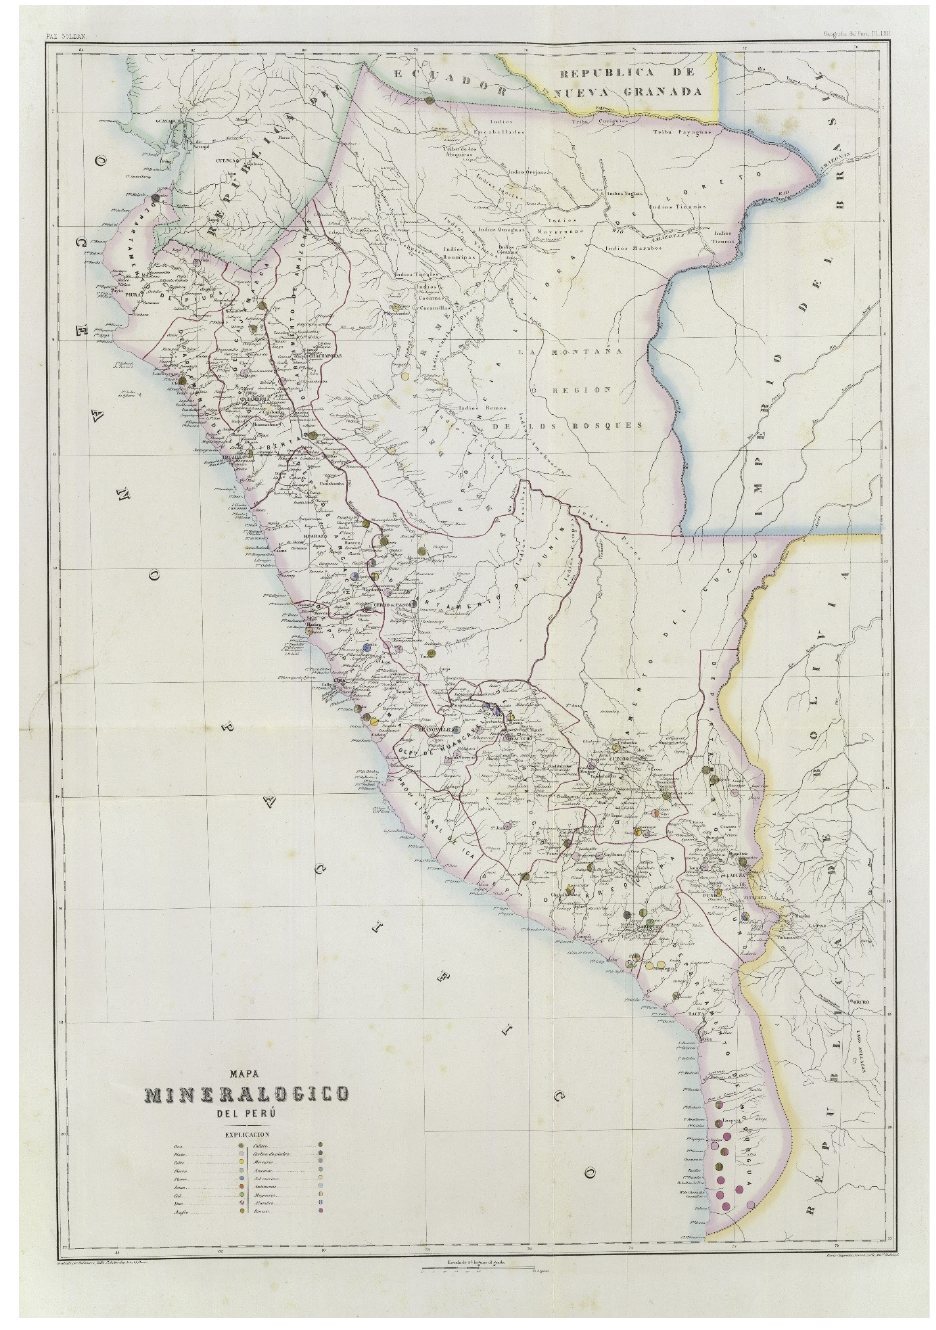
Fig. 2. Mineralogical map of Peru by M.F. Paz Soldán (source: David Rumsey Map Collection.